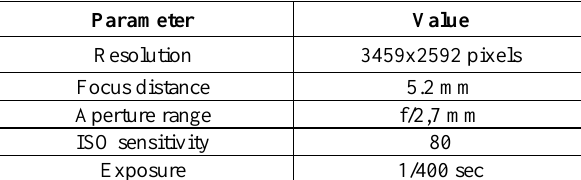
Table 1. Specification: Sony DSC-H50 digital non-metric